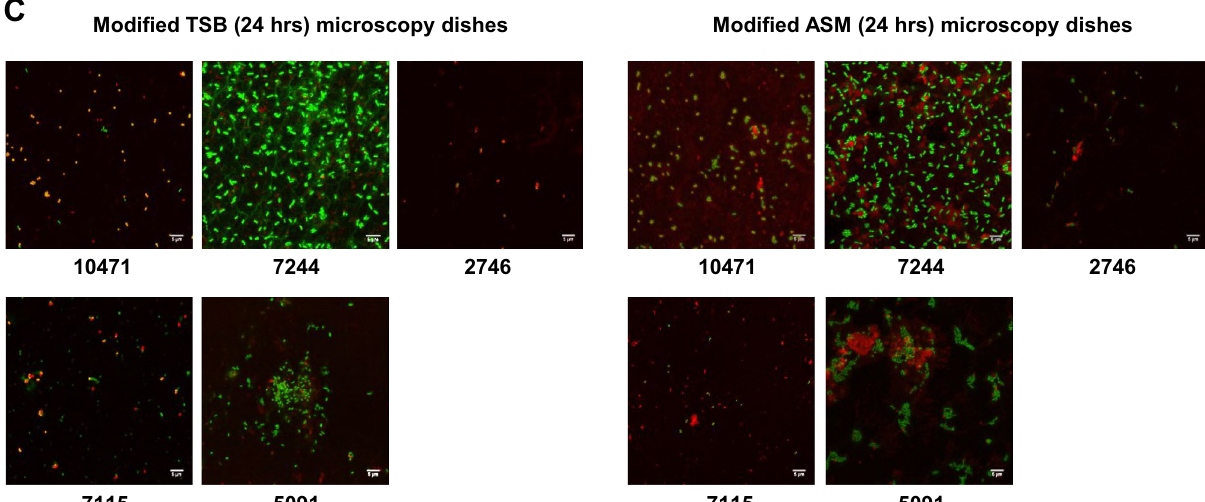
PAR7115 and PAR7244 exhibiting a dendritic swarm pattern, swarming motility increased in the presence of cell-free supernatants from its S. aureus counterpart. On the contrary, P. aeruginosa PAR10471 strain showed